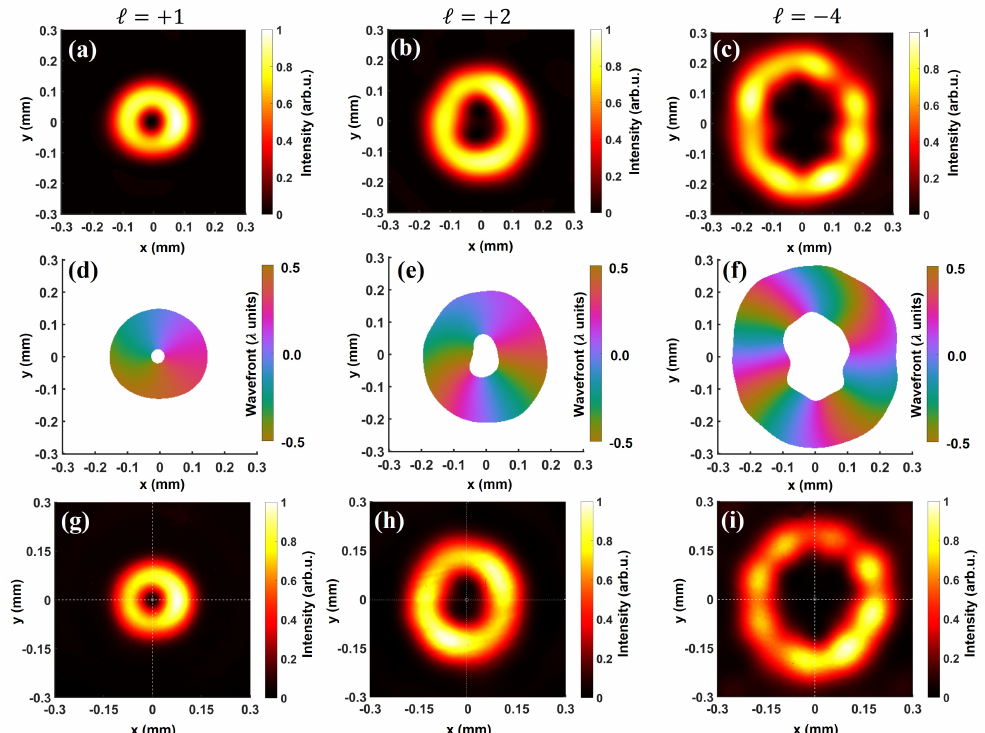
Figure 4. Fidelity of characterization: comparison between backpropagated and experimental inten- sity profile of vortex beams at the waist. We use the complex field reconstructed by the wavefront sensor to obtain intensity distribution ( top row) and the wavefront ( middle row) at the waist for (cid:96) = + 1 ( a , d , g ), + 2 ( b , e , h ), and − 4 ( c , f , i ). The backpropagated wavefronts present a variation of 1, 2, and 4 λ for | (cid:96) | = 1, 2, and 4, respectively. For each case, the bottom row represents the experimentally obtained intensity profile at the waist. For all the configurations, the backpropagated and experimen- tal profiles show an excellent agreement, indicating that the characterized amplitude and phase by the wavefront sensor indeed corresponds to the generated vortex